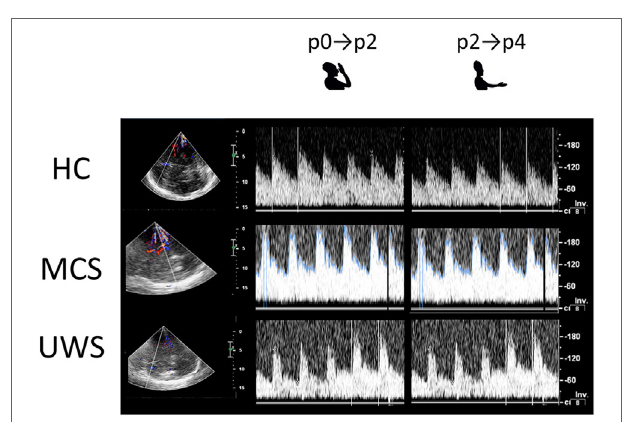
FigUre 6 | Shows the transcranial Doppler waveforms (on the right) with color Doppler (on the left) from left middle cerebral artery during motor imagery across the two hand positions (p) explored in a representative subject for each group [HC, minimally conscious state (MCS), and unresponsive wakefulness syndrome (UWS)]. Both insonation depth (left vertical bar) and flow velocity (cm/s, right vertical bar) are